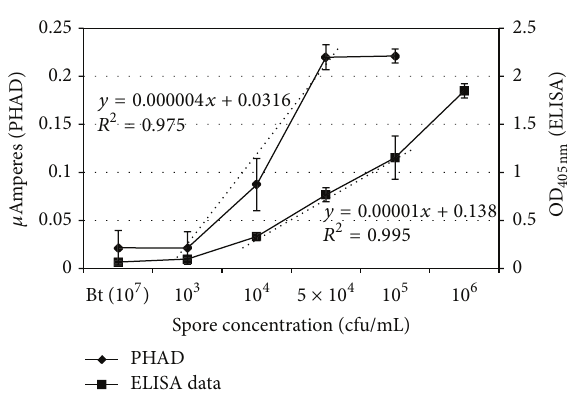
Figure 2: Linear range of PHAD compared to ELISA. PHAD has a dynamic range between 10 3 and 5 × 10 4 cfu/mL, whereas ELISA has a dynamic range between 10 4 and 10 5 cfu/mL. Spore concentrations that produce statistically saturated signals for PHAD ( 5 × 10 4 ) and ELISA (10 6 ) are indicated. Average signal for Bacillus thuringiensis ( Bt , tested at 10 7 cfu/mL) is also shown adjacent to 10 3 values for comparison. Error bars = standard deviation, dotted line = linear range.